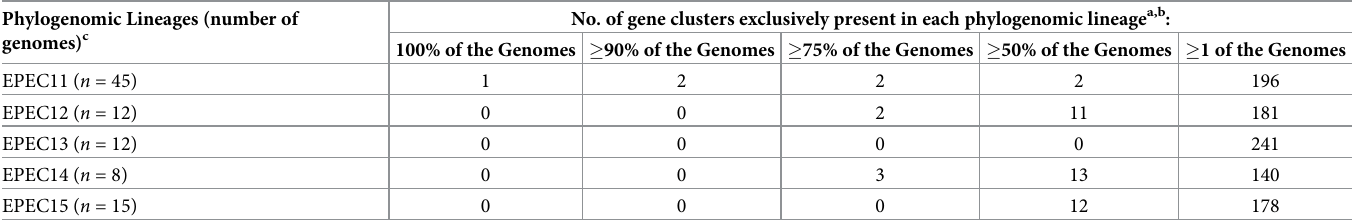
No. of gene clusters exclusively present in each phylogenomic lineage a,b